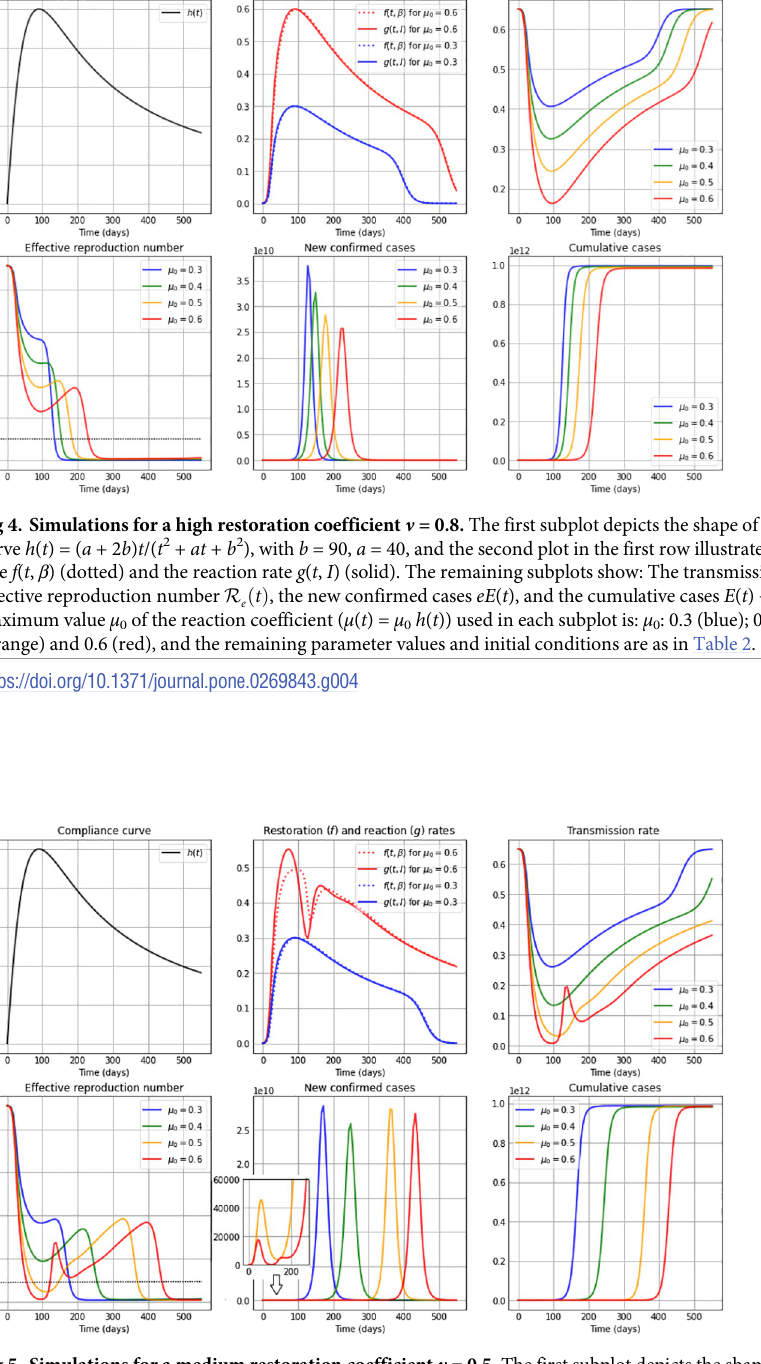
Fig 5. Simulations for a medium restoration coefficient ν = 0.5. The first subplot depicts the shape of the compliance curve h ( t ) = ( a + 2 b ) t /( t 2 + at + b 2 ), with b = 90, a = 40, and the second plot in the first row illustrates the restoration rate f ( t , β ) (dotted) and the reaction rate g ( t , I ) (solid). The remaining subplots show: The transmission rate β ( t ), the effective reproduction number R ð t Þ , the new confirmed cases eE ( t ), and the cumulative cases E ( t ) + I ( t ) + R ( t ). The e maximum value μ 0 of the reaction coefficient ( μ ( t ) = μ 0 h ( t )) used in each subplot is: μ 0 : 0.3 (blue); 0.4 (green); 0.5 (orange) and 0.6 (red), and the remaining parameter values and initial conditions are as in Table 2.